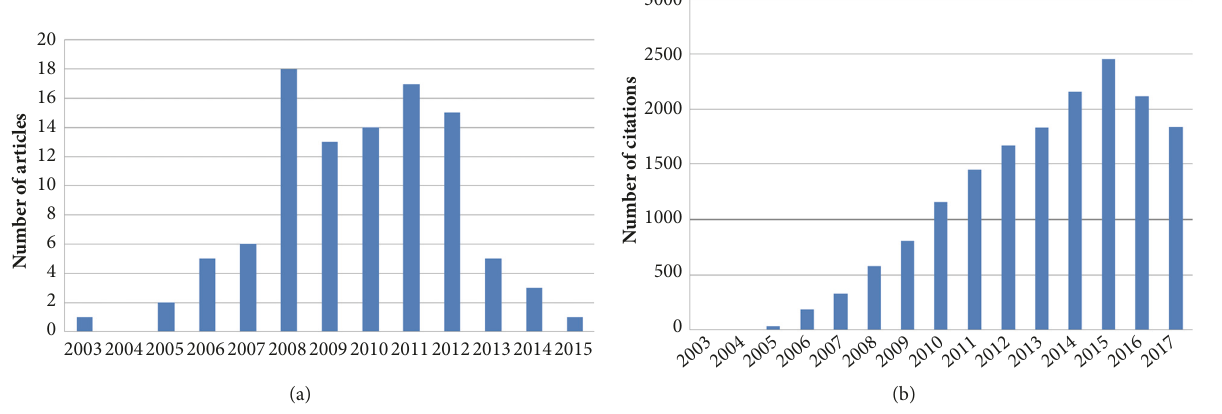
Figure 1: Developing trends in research on transient elastography. (a) The number of most-cited articles in each year. (b) The number of article citations in each year. If no article was in the list of the 100 most-cited articles in a certain year, there will be no bar shown in that year.